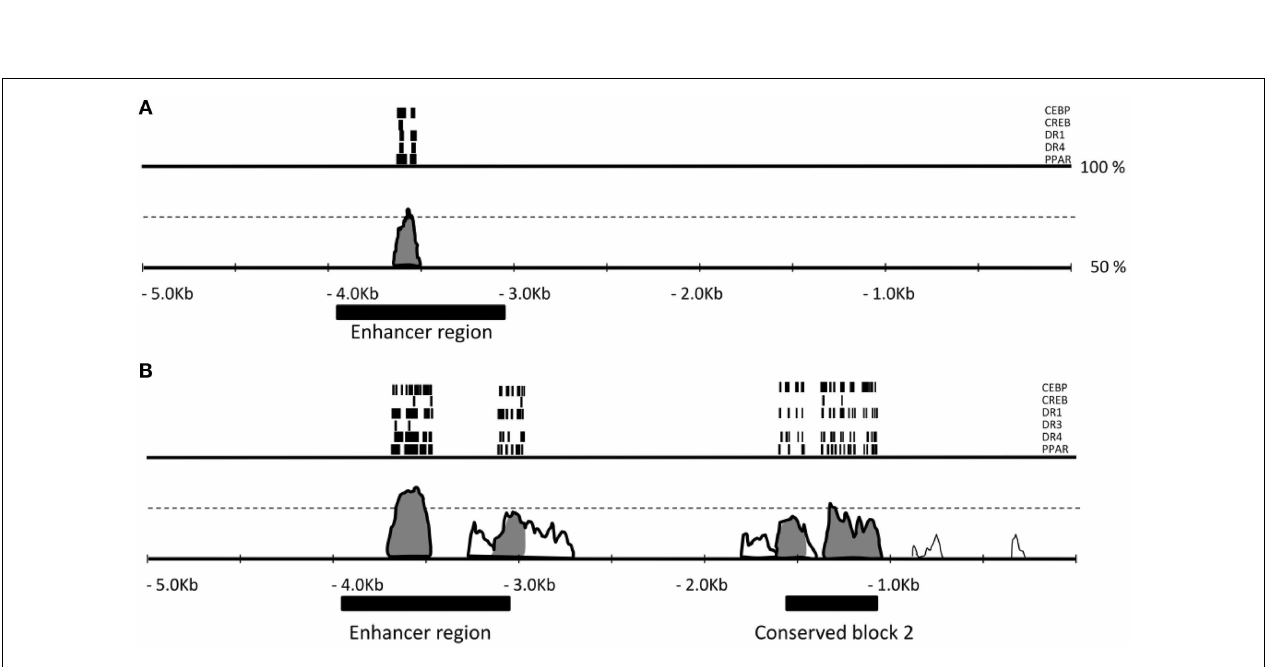
visible at approximately − 3.6Kb within the conserved enhancer region. A second conserved region approximately − 1.1 to − 1.6kb is conserved between cattle and human but is missing in the mouse genome.Within peaks of sequence similarity are a number of conserved transcription factor binding sites of interest (CEBP, CREB, DR1, DR3, DR4, PPAR) marked with the